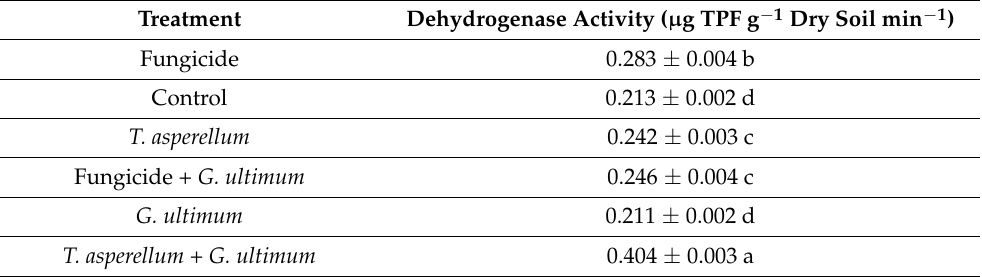
Table 7. The activity of dehydrogenase enzyme estimated in the rhizosphere soil of pea plants.